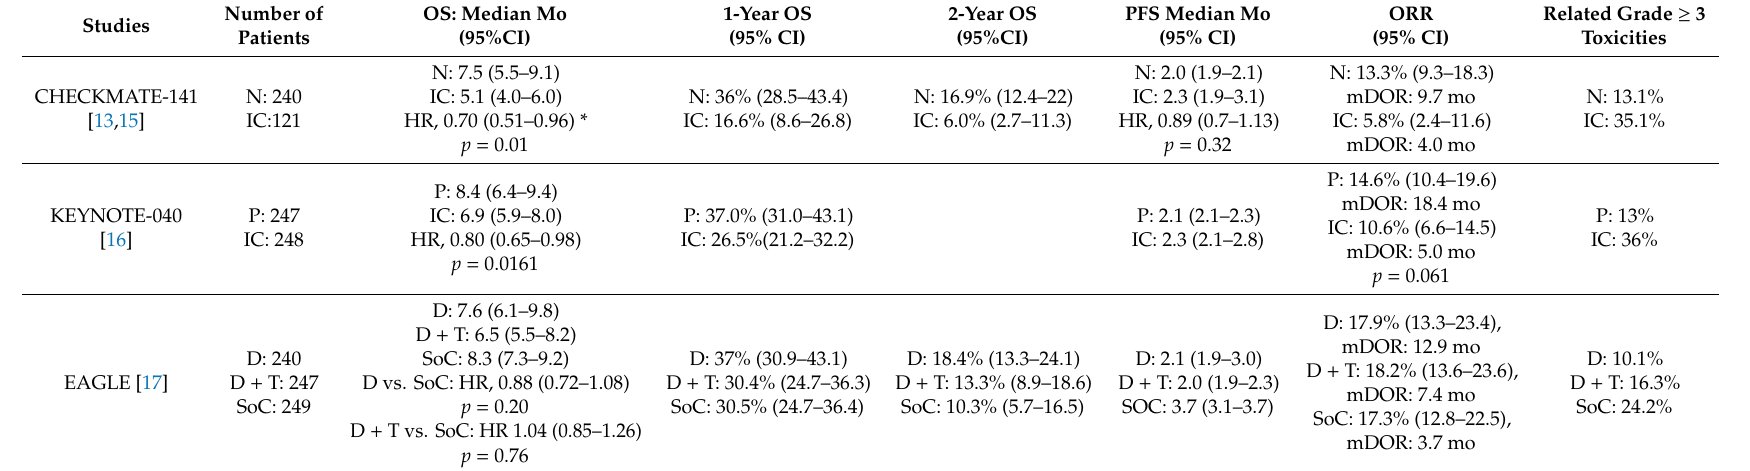
Table 2. Phase III studies in R / M platinum resistant